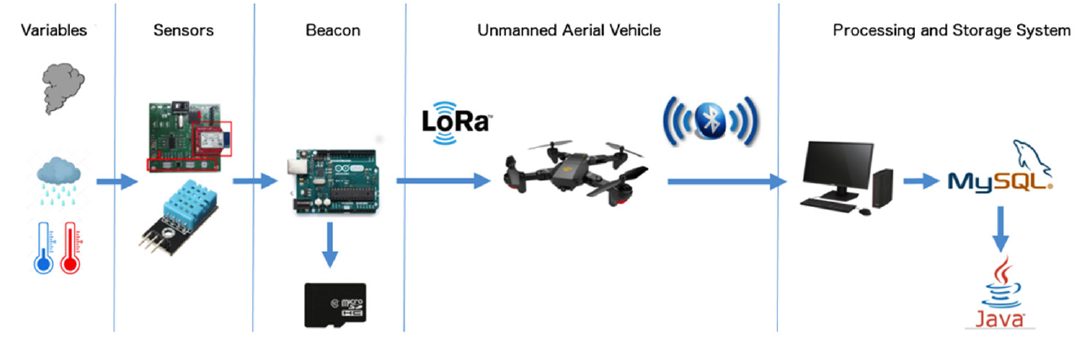
Figure 1. System scheme.